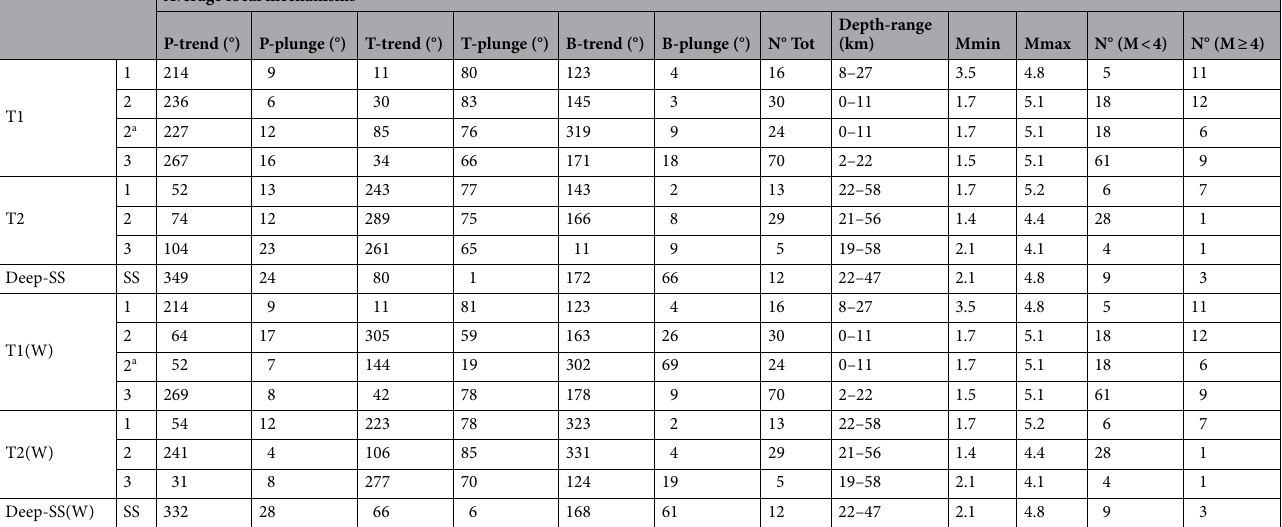
Table 1. P, T, and B axes of average focal mechanisms and weighted average focal mechanisms (W) associated with T1, T2, and deep-SS related to sector1 = 1, sector2 = 2, sector3 = 3; a Average focal mechanisms computed without considering the Ancona 1972 focal mechanisms.